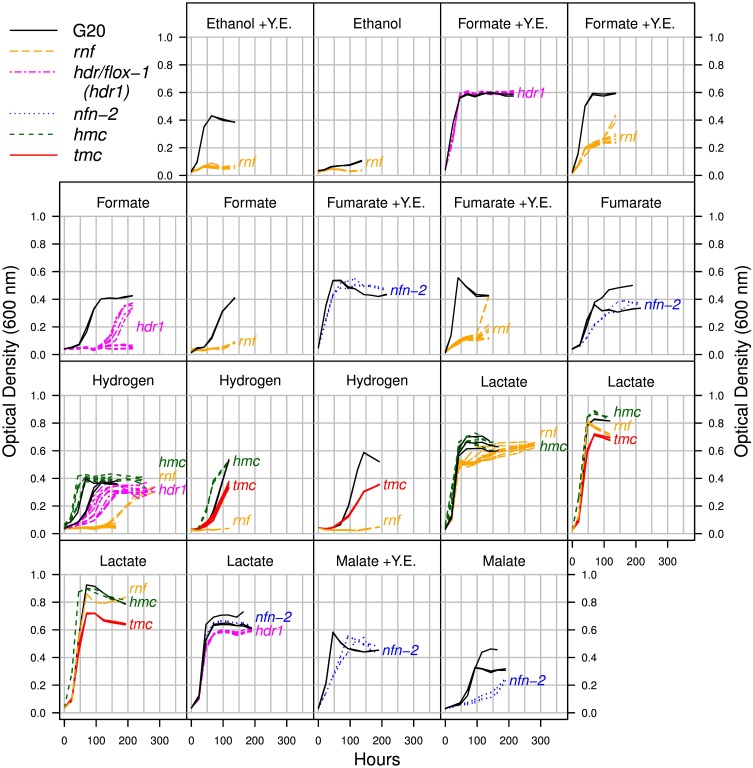
Growth of mutants in electron transport complexes Rnf, Hdr/flox-1, Nfn-2, Hmc, and Tmc, with sulfate as the electron acceptor and with a variety of electron donors. Growth of the parent strain (G20) on the same day is shown for comparison. Because results for the parent strain sometimes varied across days, we graph experiments done on different days separately. Y. E. is short for yeast extract. For each complex, we used transposon insertions in at least two different genes, and for each mutant and condition, we collected 2–4 replicates, except for floxD-1 (Dde_1210) growing on hydrogen.